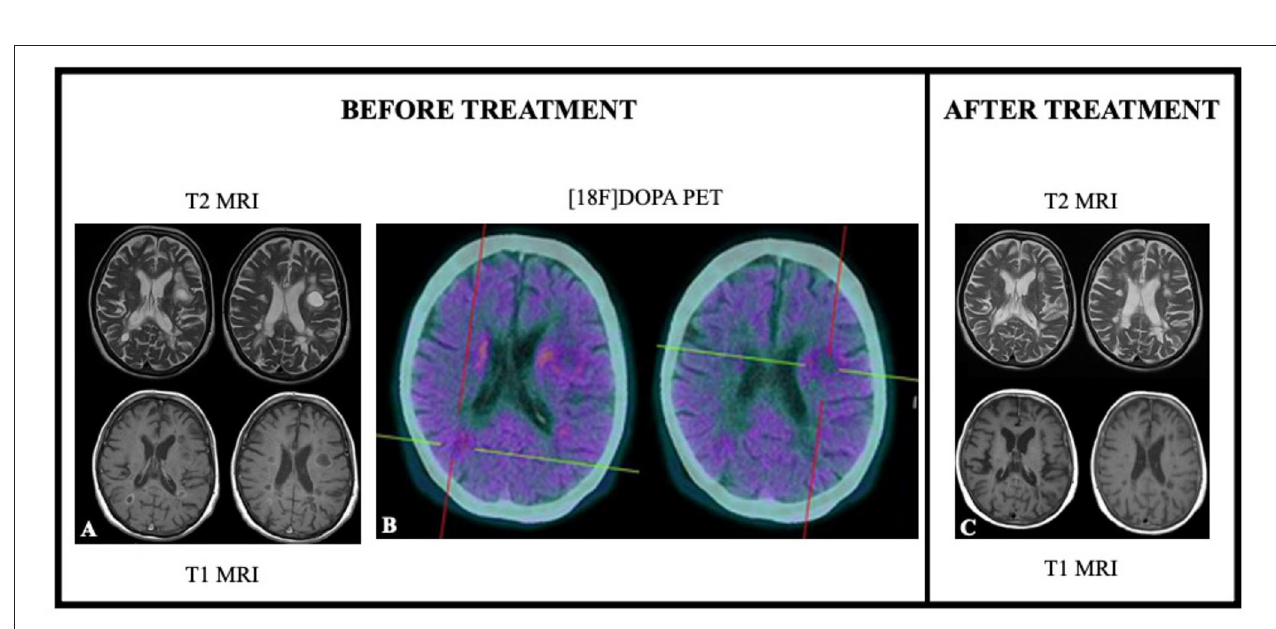
FIGURE 4 | [ 18 F]F-DOPA PET and MRI results in a case of differential diagnosis between tumefactive plaque due to multiple sclerosis and brain metastasis from breast cancer. Seventy-one years old female patient previously treated for BC. ceMRI showed the presence of at least two hyperintense at T2 sequences (A) and hypointense at T1 sequences (A) (the largest in left frontal lobe). [ 18 F]F-DOPA PET/CT showed a very mild tracer uptake supporting the hypothesis of tumefactive lesion due to multiple sclerosis (B) . ceMRI performed 3 months after therapy administration showed reduction in both lesion size and contrast enhancement (C) .